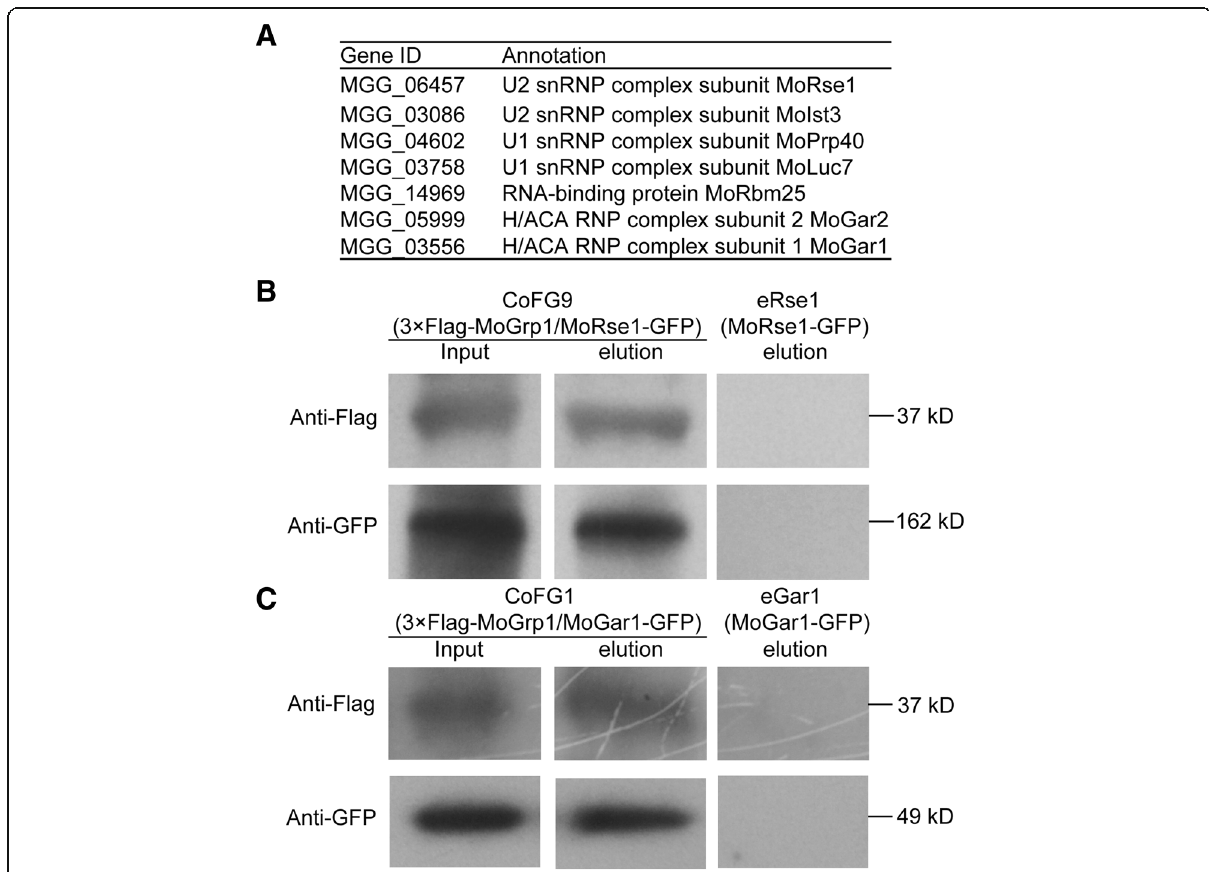
Fig. 5 MoGrp1 can be co-immunoprecipitated with components of the spliceosome. a List of proteins co-immunoprecipitated with 3×Flag- MoGrp1; b Immunoblot of the total protein (input) and those eluted from anti-FLAG M2 beads (elution) of strain CoFG9 expressing both the MoRse1-GFP fusion protein and the 3 × Flag-MoGrp1 fusion protein. Strain eRse1 expressing the MoRse1-GFP fusion was used as control. The MoRse1-GFP fusion protein and the 3×Flag-MoGrp1 fusion protein were probed with an anti-GFP antibody and an anti-Flag antibody, respectively; c Immunoblot of the total protein (input) and those eluted from anti-FLAG M2 beads (elution) of strain CoFG1 expressing both the MoGar1-GFP fusion and the 3×Flag-MoGrp1 fusion. Strain eGar1 expressing the MoGar1-GFP fusion was used as control. The MoGar1-GFP and the 3×Flag-MoGrp1 fusion proteins were probed with an anti-GFP antibody and an anti-Flag antibody,